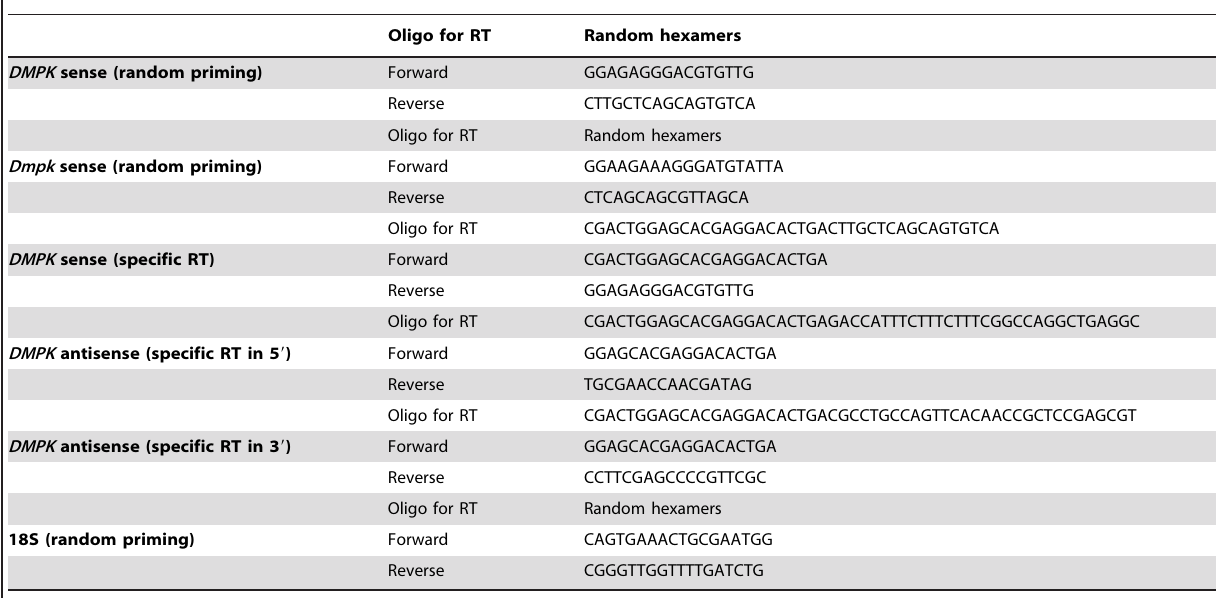
Table 2. List of primers used for expression